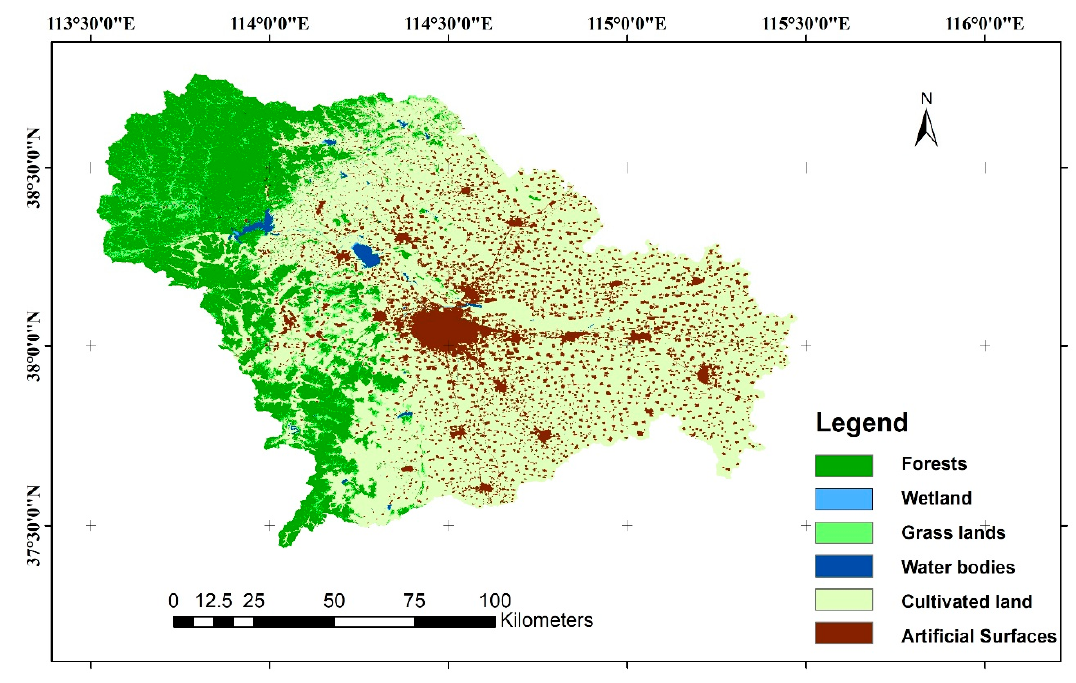
Figure 3. Land use/cover raster of Shijiazhuang.